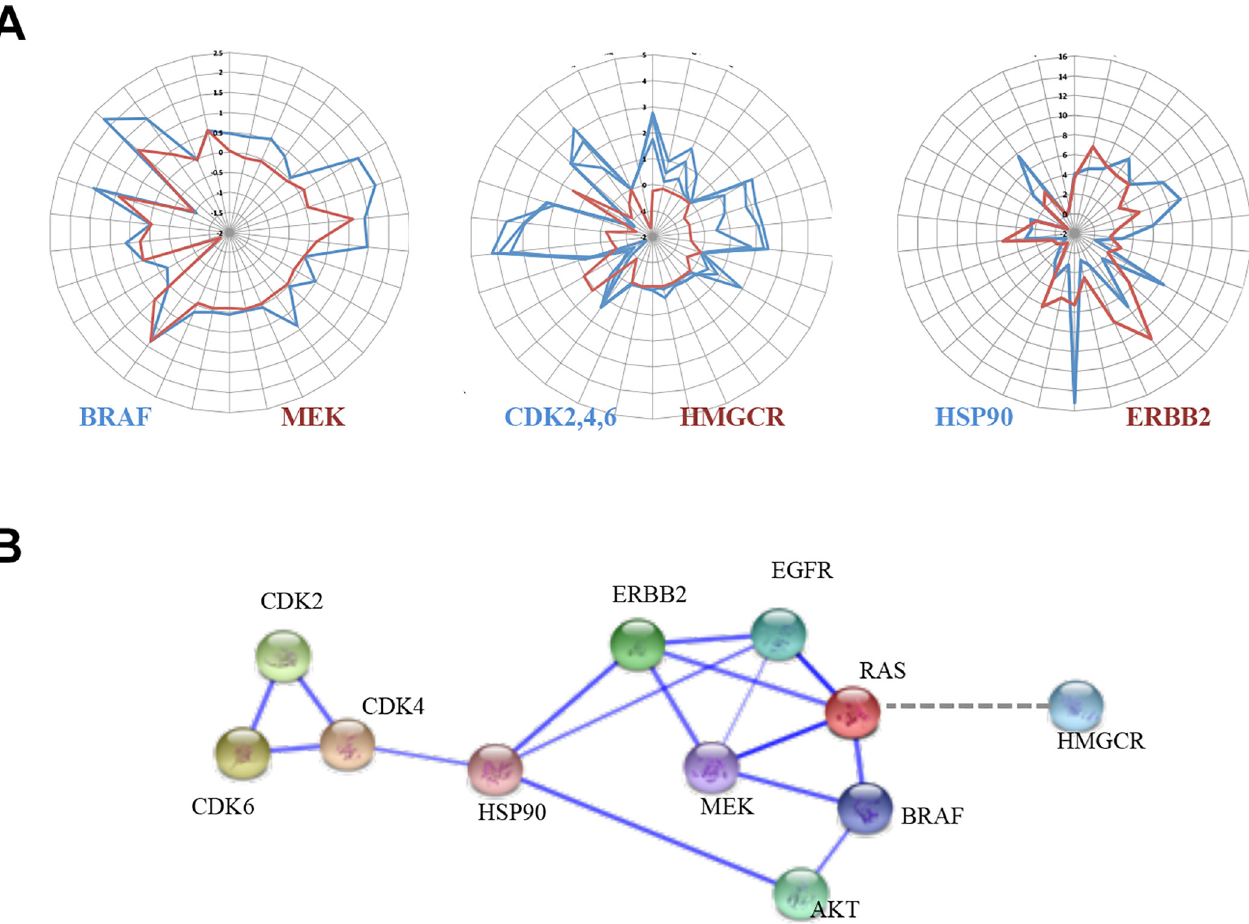
Fig 3. Network profiles and interactions between targets of drug combinations. A) Radar plots showing representative network property profiles of targets of drug combination. MEK and BRAF network property profiles are more similar to one another than the network profiles of CDKs and HMGCR. This may be related to the long-term effectiveness of the combinations of drugs targeting these proteins. B) Interactions between proteins targeted by drug combination showing high level of connectivity between targets such as EGFR, BRAF and MEK. The dotted edge indicates that no direct interaction takes place between HMGCR and the other proteins in the